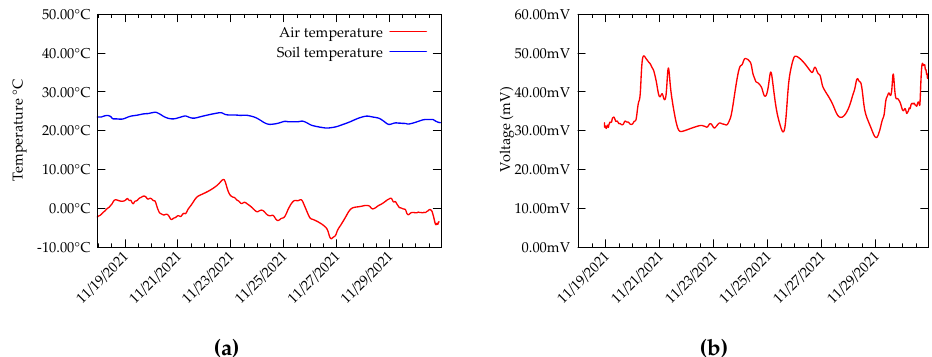
Figure 4. Data from test bed deployed in Forhot reseach site, Iceland. ( a ) Soil temperature (TEG hot side) and Air temperature (TEG cold). ( b ) TEG open circuit voltage.